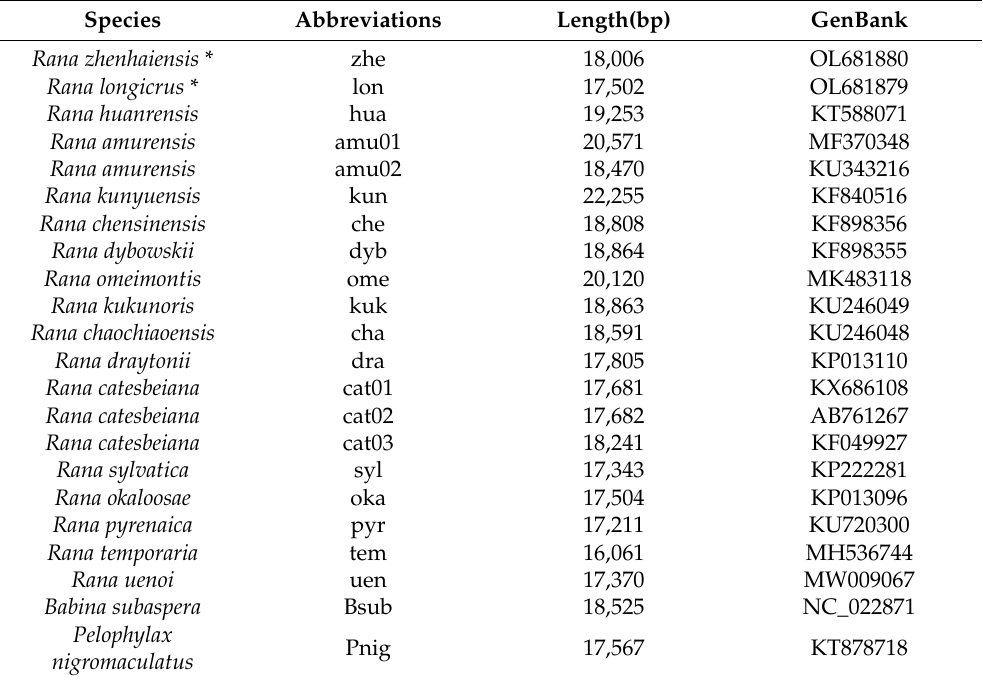
Table 1. Species used in this